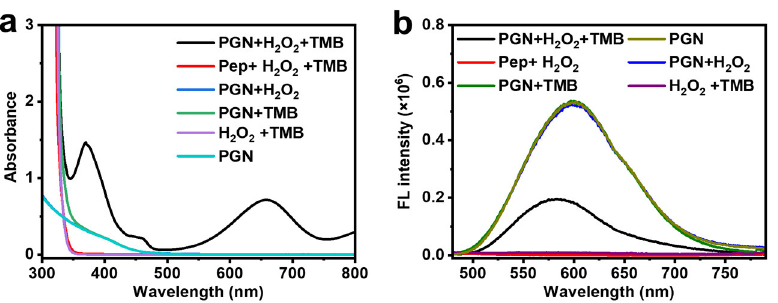
Figure 2. Catalytic properties of the PGN: ( a ) absorption and ( b ) fluorescence spectra for the PGN- H 2 O 2 -TMB system and the related control systems.